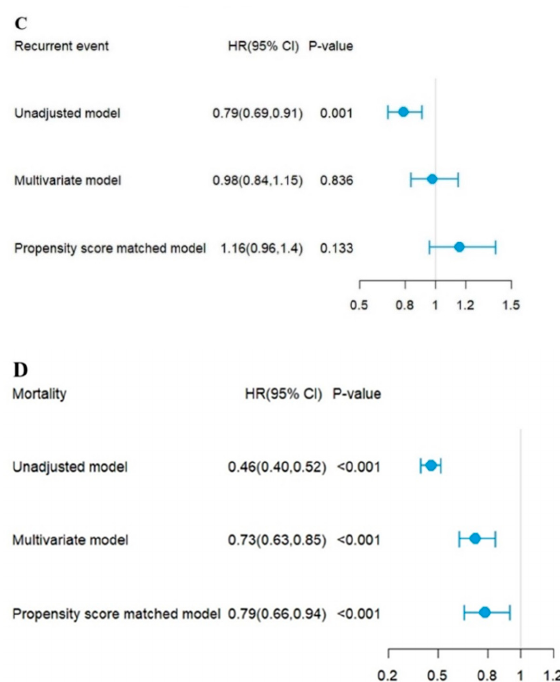
Figure 4. The impact of the PNI group on the long-term outcome using ( A ) Kaplan-Meier curves for the occurrence of cancer recurrence, ( B ) Kaplan-Meier curves for mortality, ( C ) Hazard ratio for the occurrence of cancer recurrence in the PNI group, and ( D ) Hazard ratio for mortality in the PNI group.